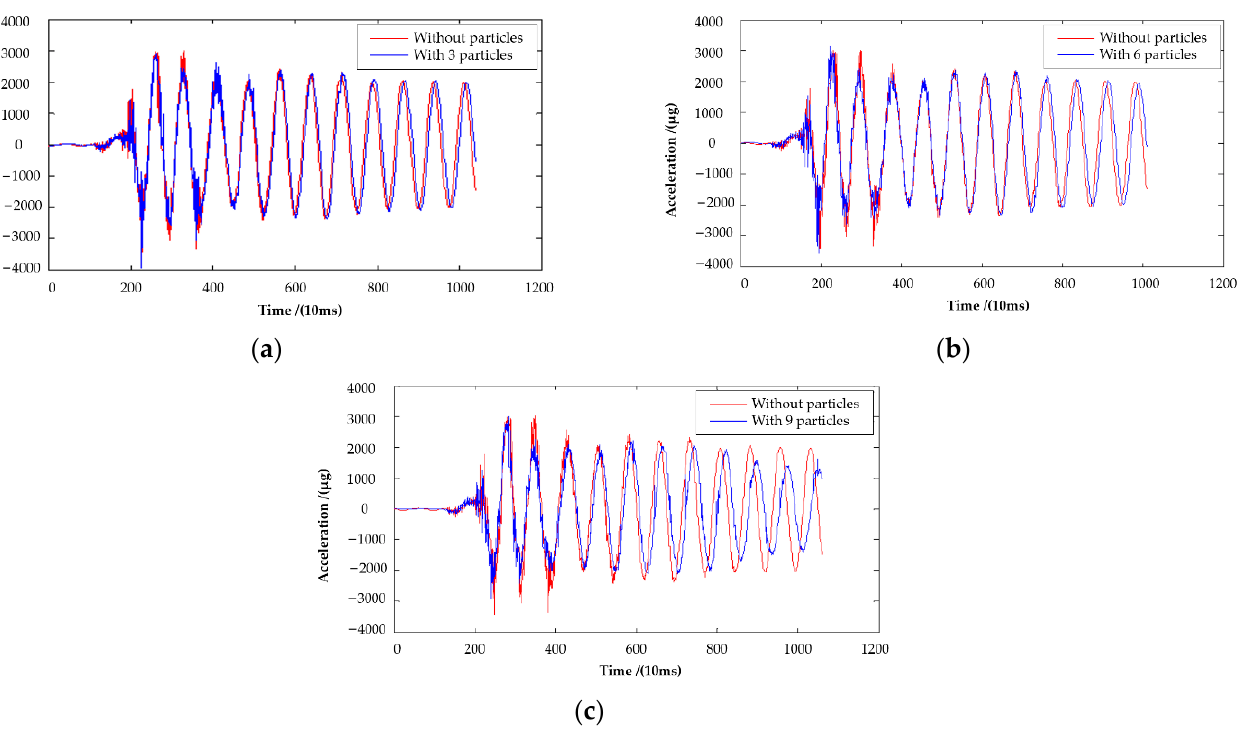
Figure 8. Acceleration responses of 3% mass ratio under El-Centro wave: ( a ) the particle number is 3;